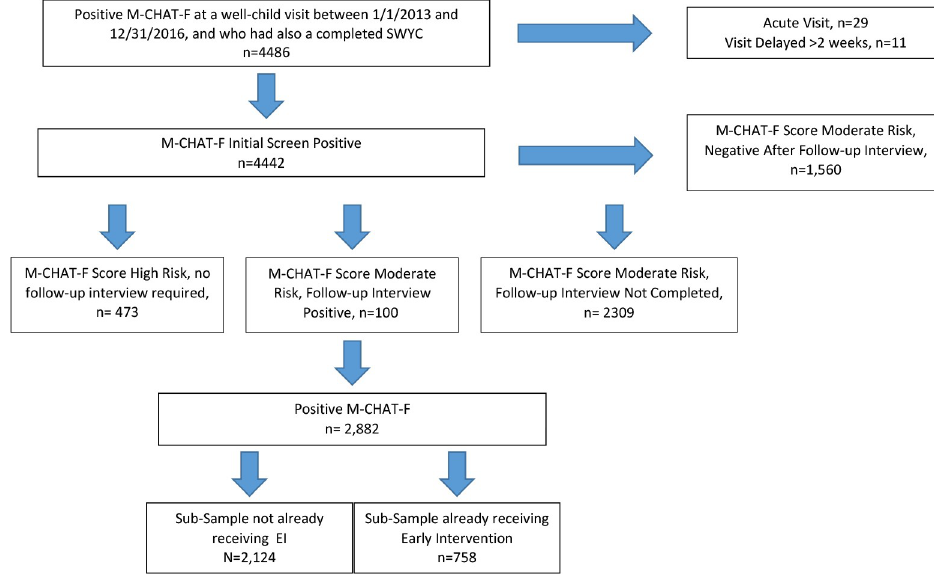
Fig 1. Sample inclusion for final